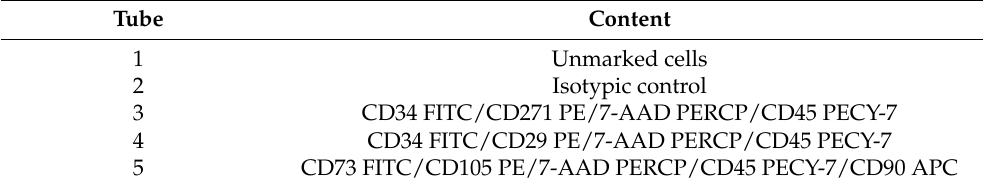
Table 1. Cytometry